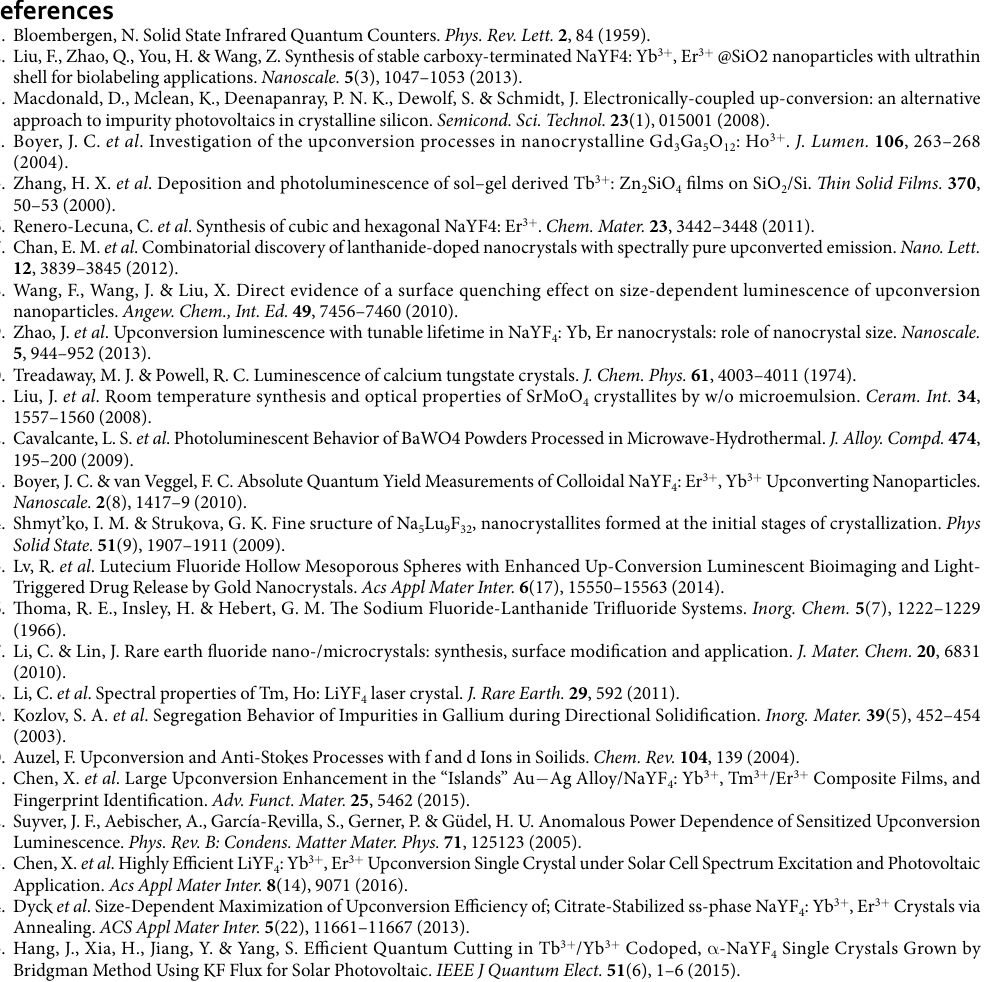
Characterization. X-ray diffraction (XRD) of the samples was measured using a D8 Advance diffractometer (BRUKER, German). The absorption spectra were recorded with a Cary 5000 UV/VIS/NIR spectrophotometer (Agilent Co., America). The emission spectra were obtained with a FLSP 920 type spectrometer (Edinburgh Co., England). The external quantum efficiency were measured by a fluorescence spectrometer (FLS 980) of Edinburgh instruments combined with an integrating sphere. All the measurements were measured at room temperature. The actual concentrations of Er 3 + and Yb 3 + ions in all the samples were measured by an inductively coupled plasma atomic emission spectroscopy (ICP-AES, Perk in Elmer Inc., Optima 3000). The measured Er 3 + and Yb 3 + concentrations in all crystals are presented in Table 1.